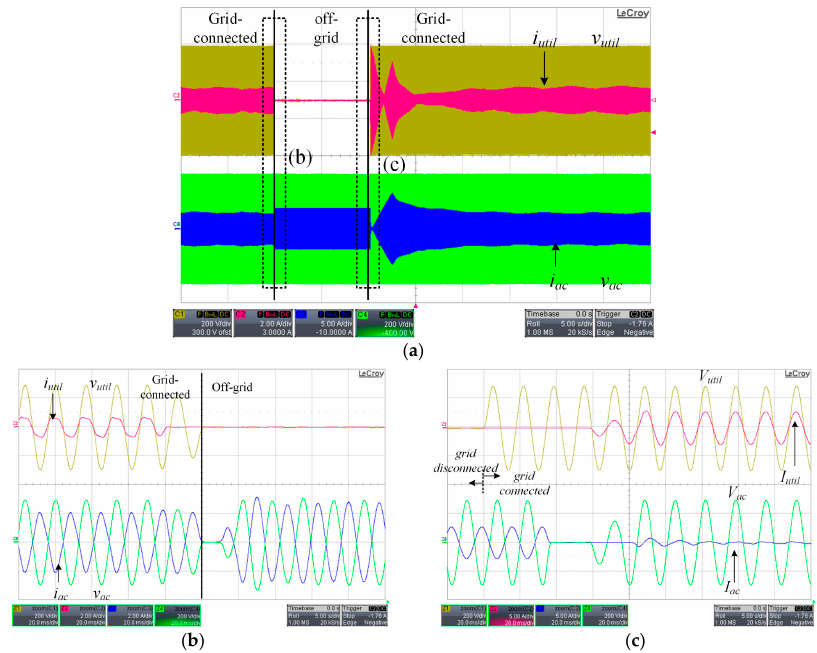
Figure 14. State transition of GC according to the grid condition. ( a ) Transition of GC; ( b ) zoomed-in waveforms during transition of grid-connected to off-grid; and ( c ) zoomed-in waveforms during transition of off-grid to grid-connected.